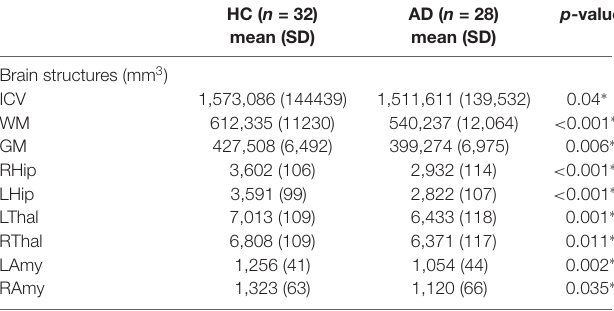
it is noticeable that the hippocampi have dominant